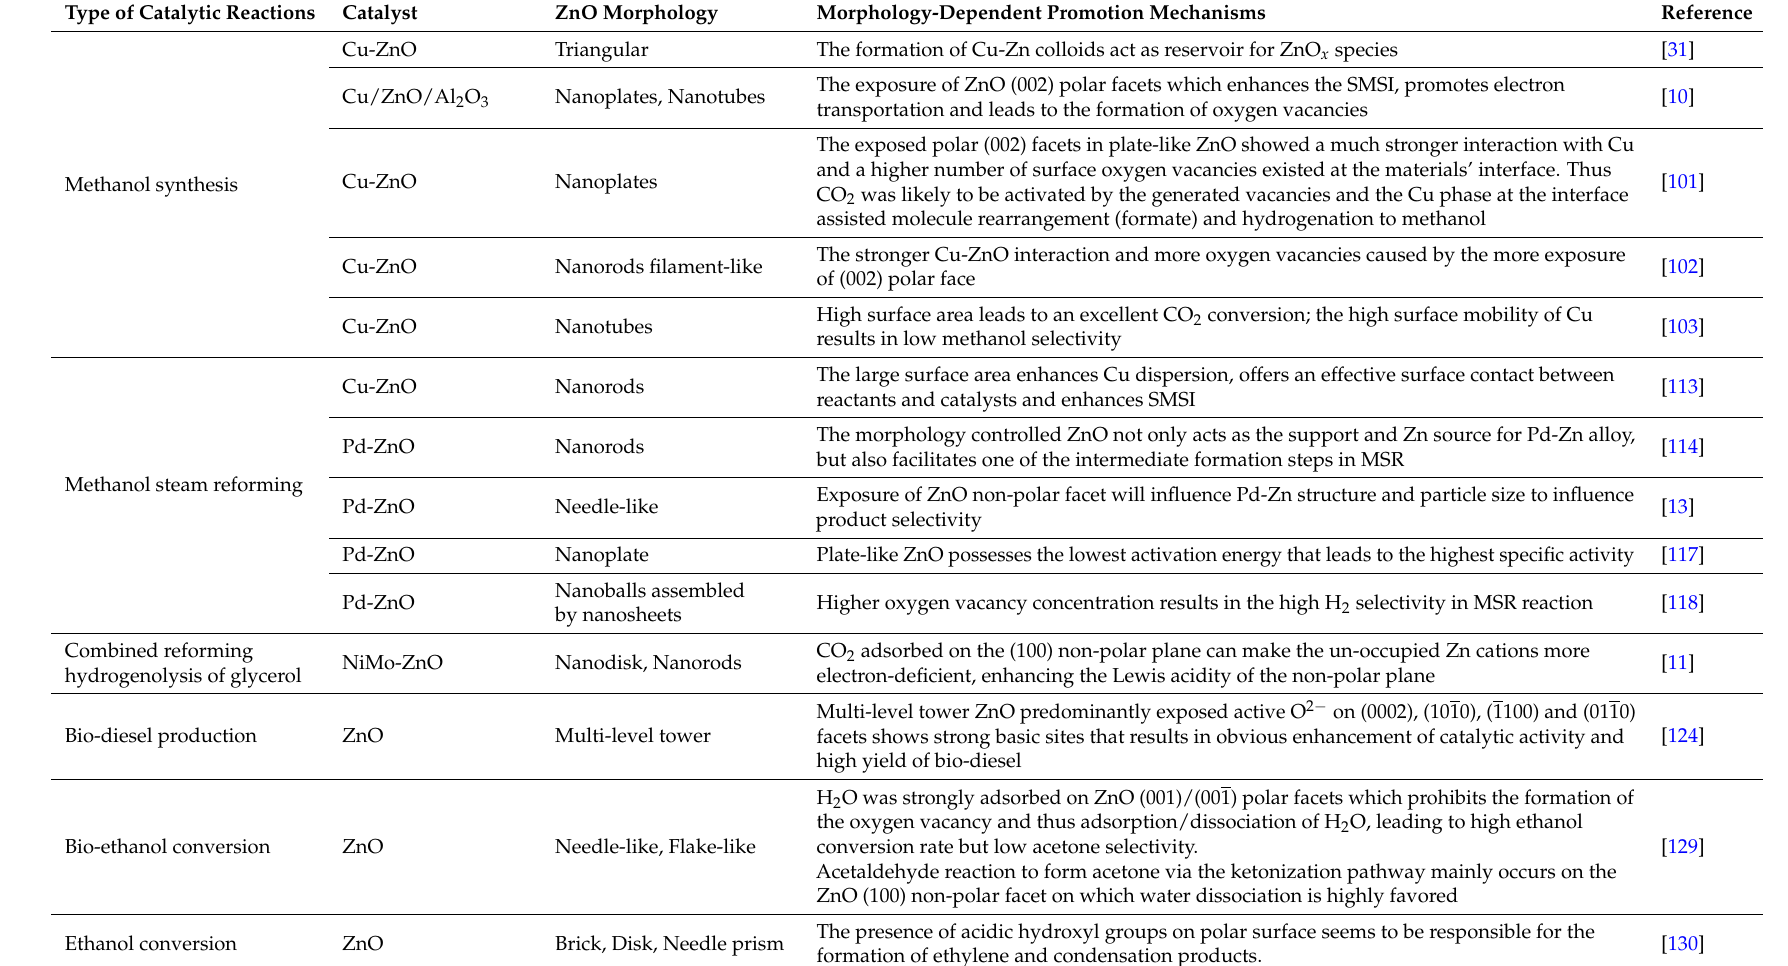
Table 1. The applications of morphology controlled ZnO in the thermo-catalytic